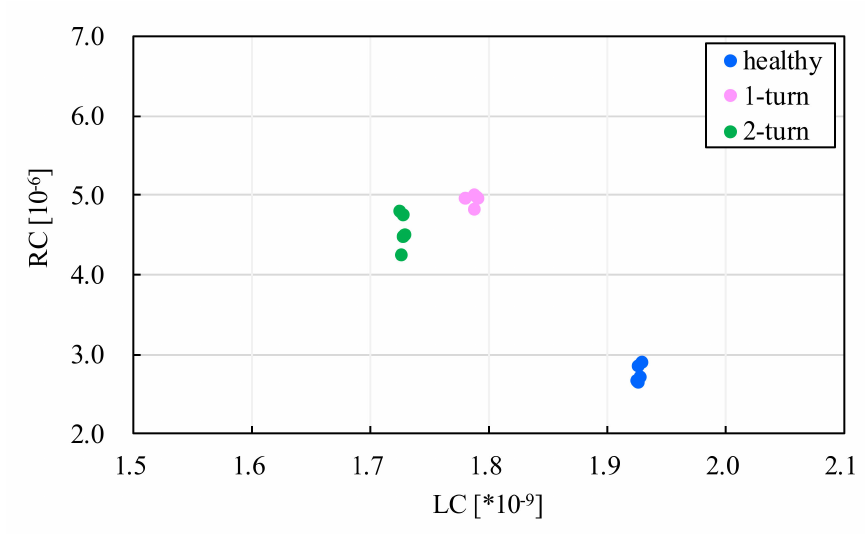
Figure 11. Feature distribution for the 2.2-kW motor